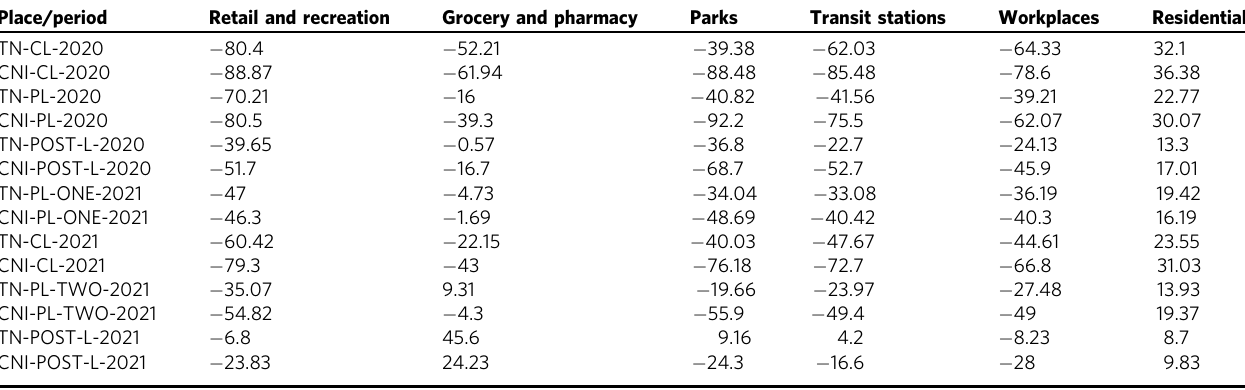
Table 2 Percentage change in mobility across six community spaces (land use functions) in Tamil Nadu and Chennai City during various phases of lockdown in both the pandemic waves in 2020 – 2021.